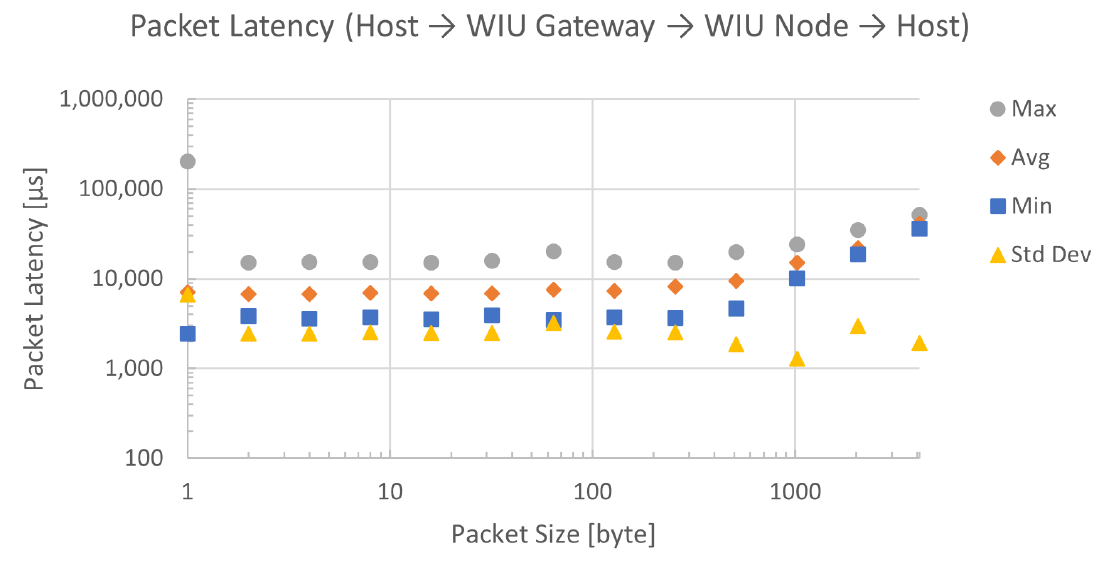
Figure 9. Packet latency for a bridged connection over WIU gateway to WIU node. As expected, additional stops in the transmission path added latency. While a direct connection had an average latency of around 2 ms, the employment of the wireless nodes as bridges resulted in an average latency of around 7 ms. For packet sizes over 100 bytes, the latency started to rise. In order to minimize latency, a custom ISA100 frame with a payload size of 800 bytes was used instead of the default ISA100 127-byte